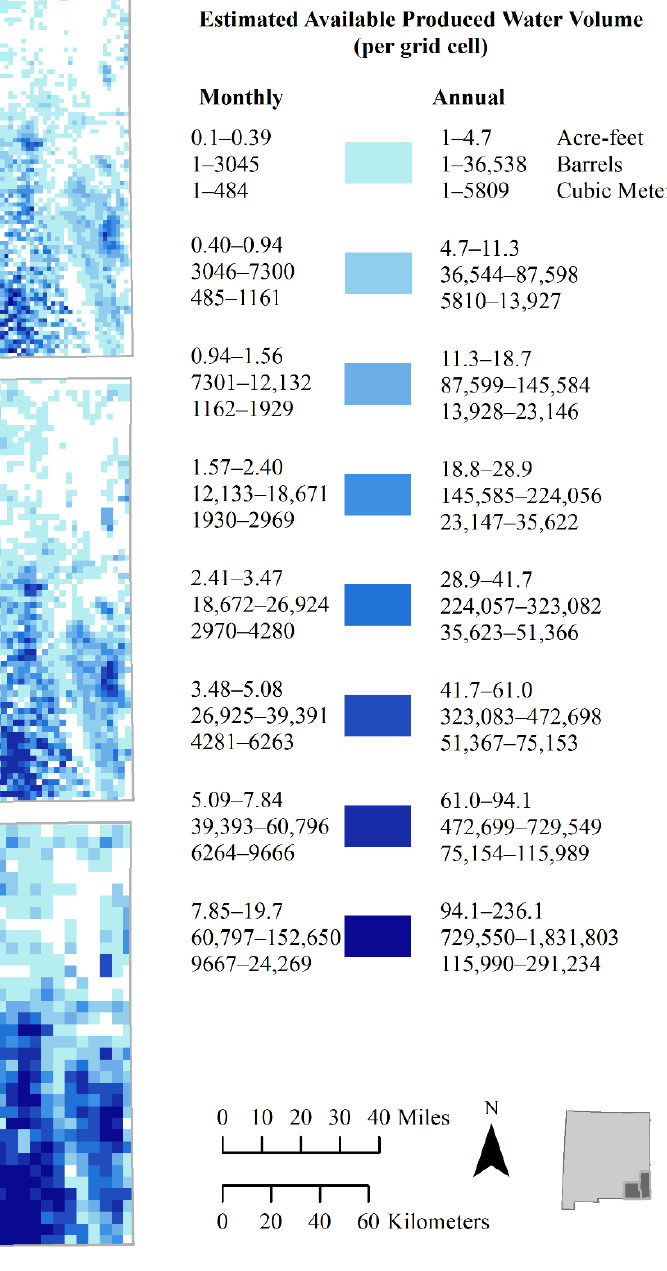
Figure 6. Estimated available treated produced water per grid cell in Eddy and Lea counties based on 2021 data.